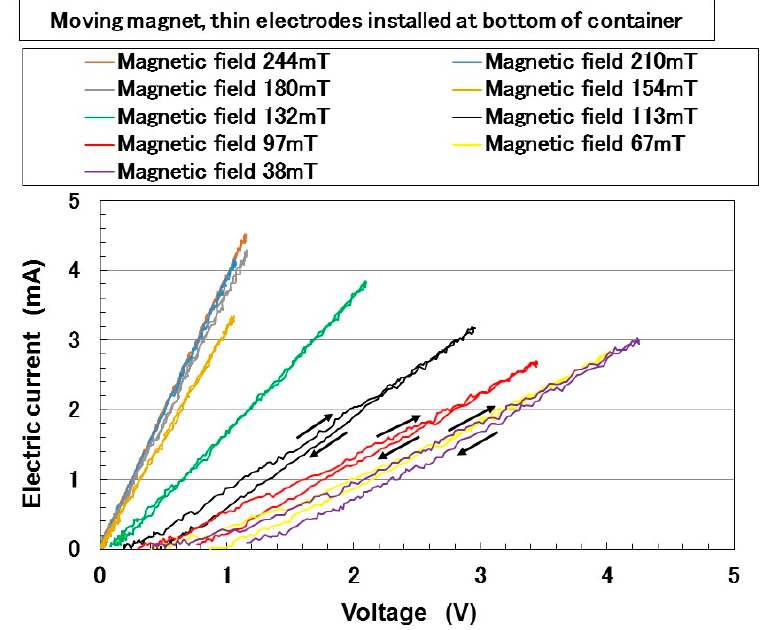
Figure 10. Comparison of electric conductivity between thin and thick electrodes for a moving magnet and with electrodes installed at the bottom of the container.